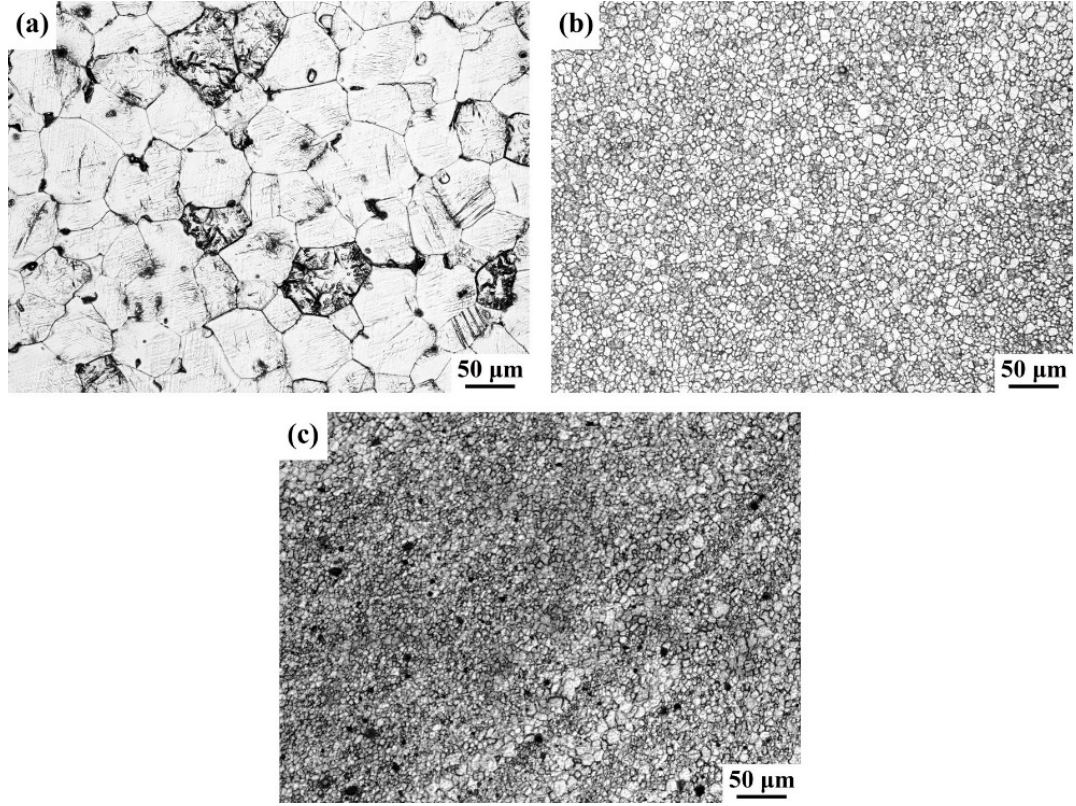
Figure 4. Optical image of ( a ) base metal (BM); ( b ) friction stir processing (FSP)-WE43; and ( c ) WE43/nHA specimens.